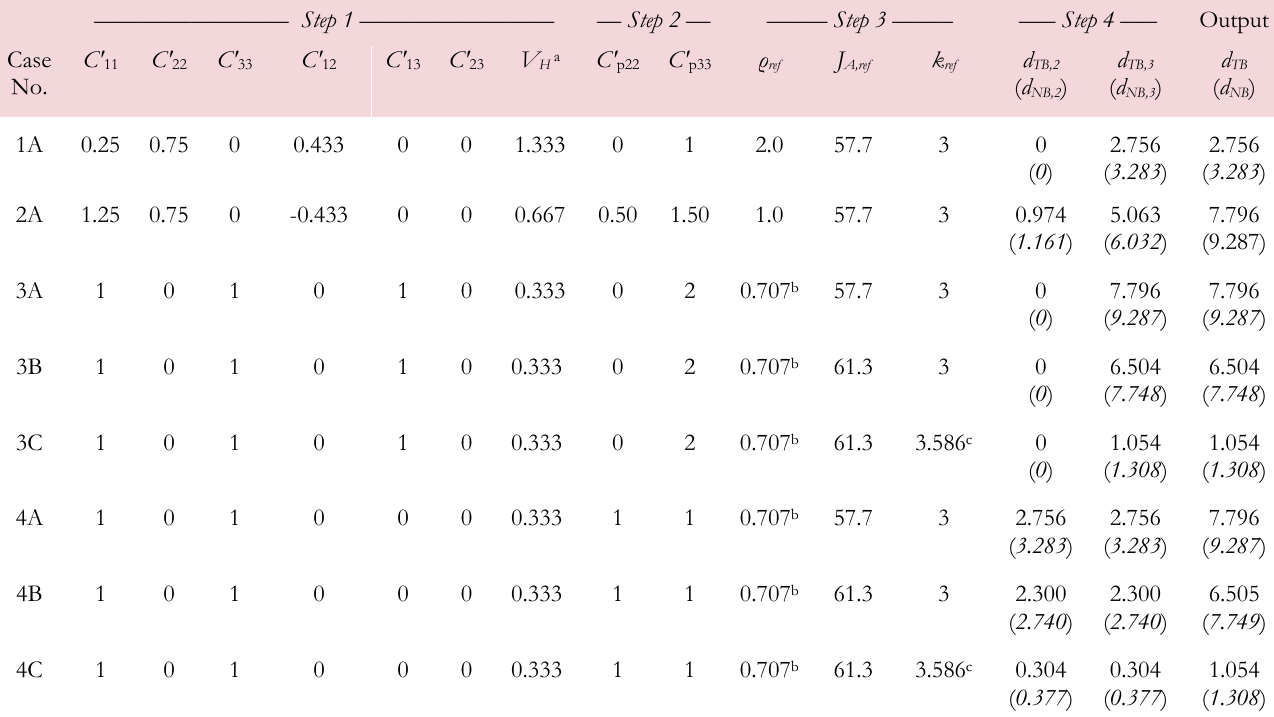
Table 4: Summary of step-by-step results (only non-zero values) of numerical case studies. In Step 4 and Output, the damage values are multiplied by 10 10 (Notes: a 1.333=4/3, 0.667=2/3, 0.333=1/3; b 2/1707.0  ; c 25586.3 